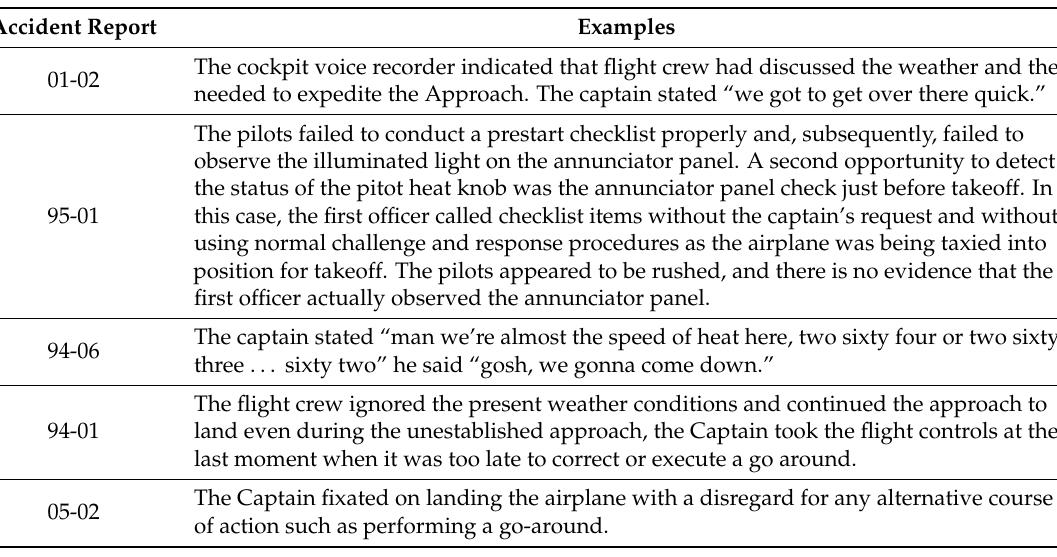
Table 6. Examples of Get-There-Itis.